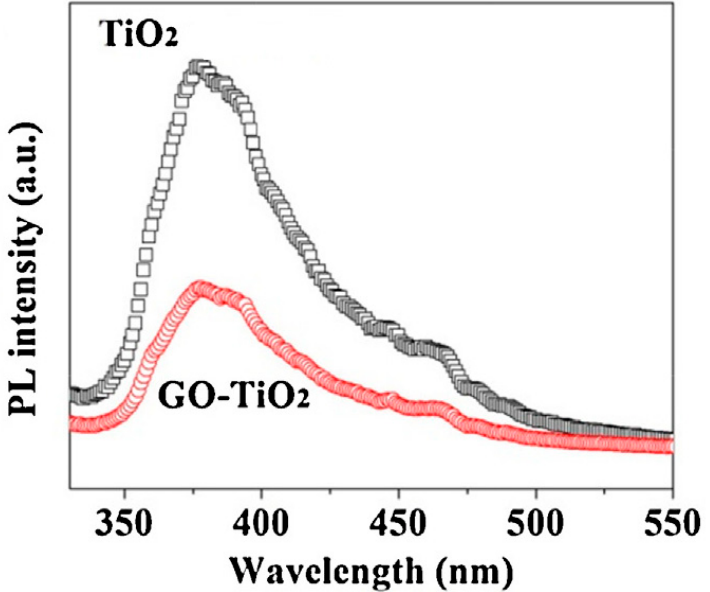
Figure 20. PL spectra of bare TiO 2 and TiO 2 /GO nanocomposites. Reprinted with permission from reference [124]. Copyright 2014 Elsevier.